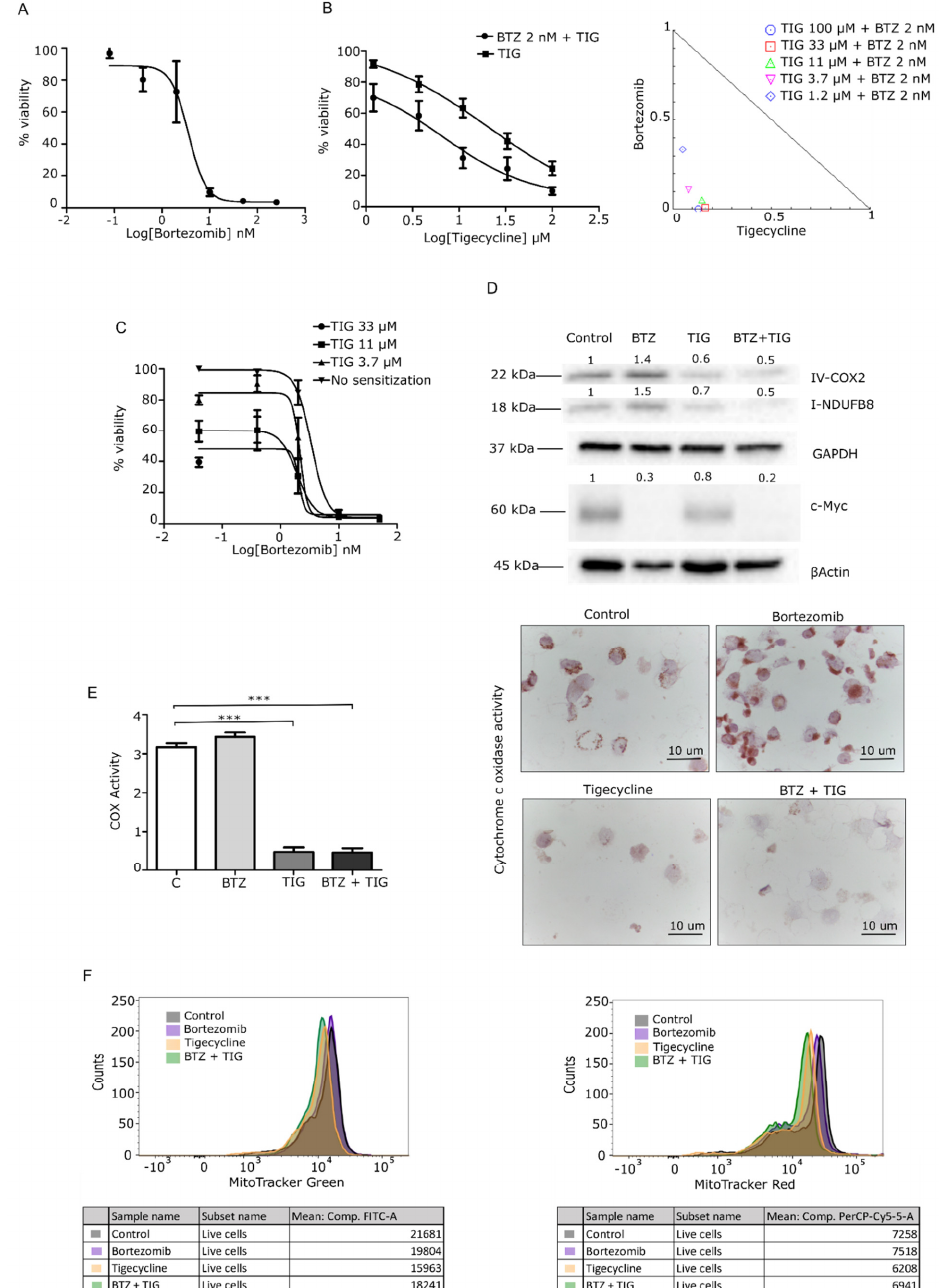
Figure 3. Tigecycline and the combination with bortezomib inhibits cancer cell growth and mitochondrial activity in the JJN3 cell line. ( A ) Cells were treated with a dose range of 0–250 nM of BTZ, and viability was determined using the calcein cytotoxic assay. ( B ) Cells were treated with a dose range of 0–100 µ M of TIG with/without 2 nM BTZ, and viability was determined using the calcein cytotoxicity assay. TIG showed an IC50 of 21.3 µ M in JJN3 cells, and the combination decreased threefold the IC50 value (6.6 µ M). Isobologram plot of the combination; dots indicate the combinatory index (CI) of each combinatory dose. ( C ) IC50 curve after treating cells for 48 h with TIG for consecutive 48 h with bortezomib. Data are normalized to the negative control (DMSO) and presented as mean values ± SEM of technical triplicates. ( D – F ) molecular validation of mitochondrial inhibition of JJN3 cells treated with 3.7 µ M TIG, 2 nM BTZ, or both (combination). All of the drug treatments were for 48 h; N = 1 independent biological repeat. ( D ) WB of respiratory chain complexes I and IV and c-Myc. ( E ) HE-COX analysis in >10 cells per sample. ( F ) Multiparametric flow cytometry (MFC) analysis of MitoTracker green ( left , mitochondrial mass) and Red ( right , mitochondrial membrane potential). Representative histograms show cell counts for each probe on the different treatment conditions. *** p <